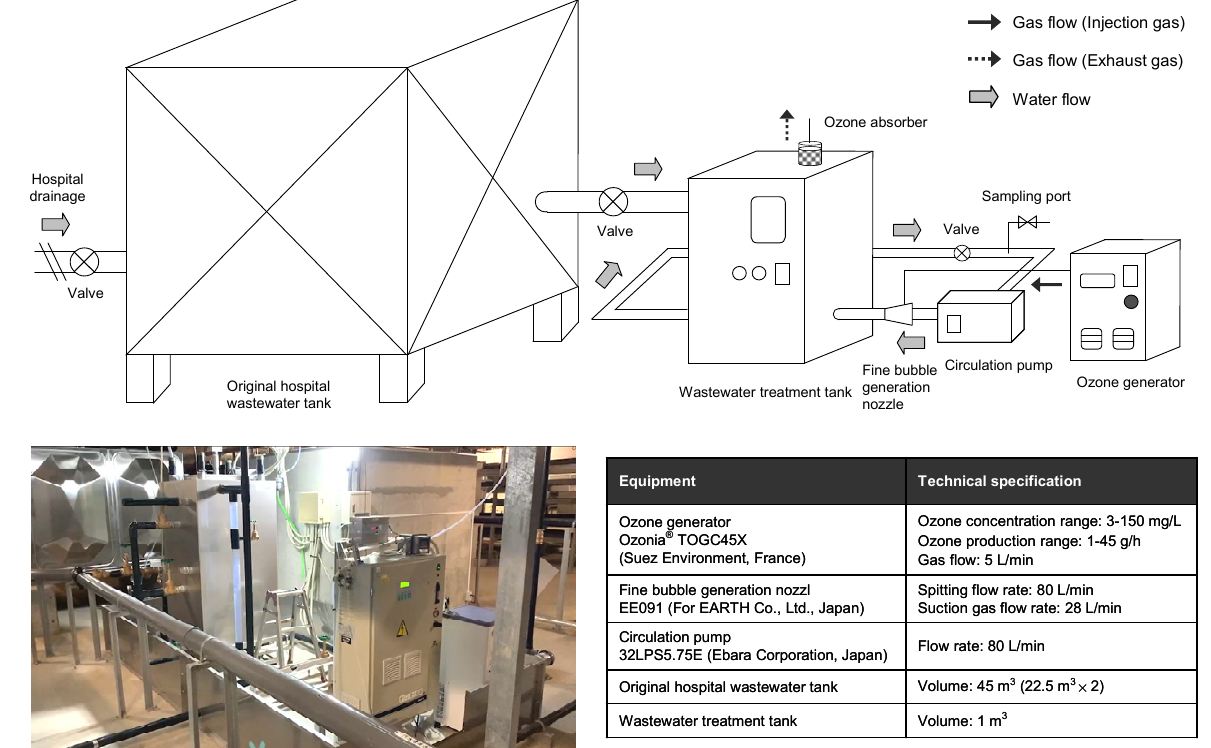
Figure 1. Schematic representation of the batch ozone treatment system implemented in a hospital facility. The picture shows the appearance of the advanced hospital wastewater treatment system equipped with the ozone treatment system that was tested in this study. The technical specifications of the equipment used in the system are shown in detail.